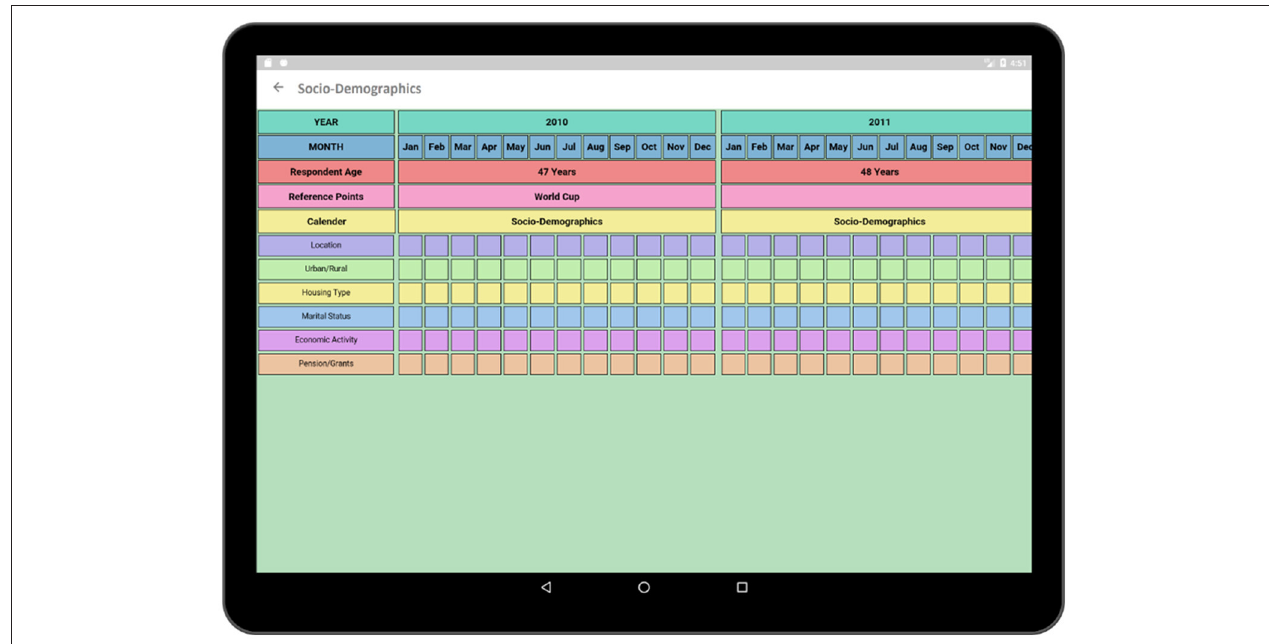
FIGURE 7 | Socio-demographics (calendar